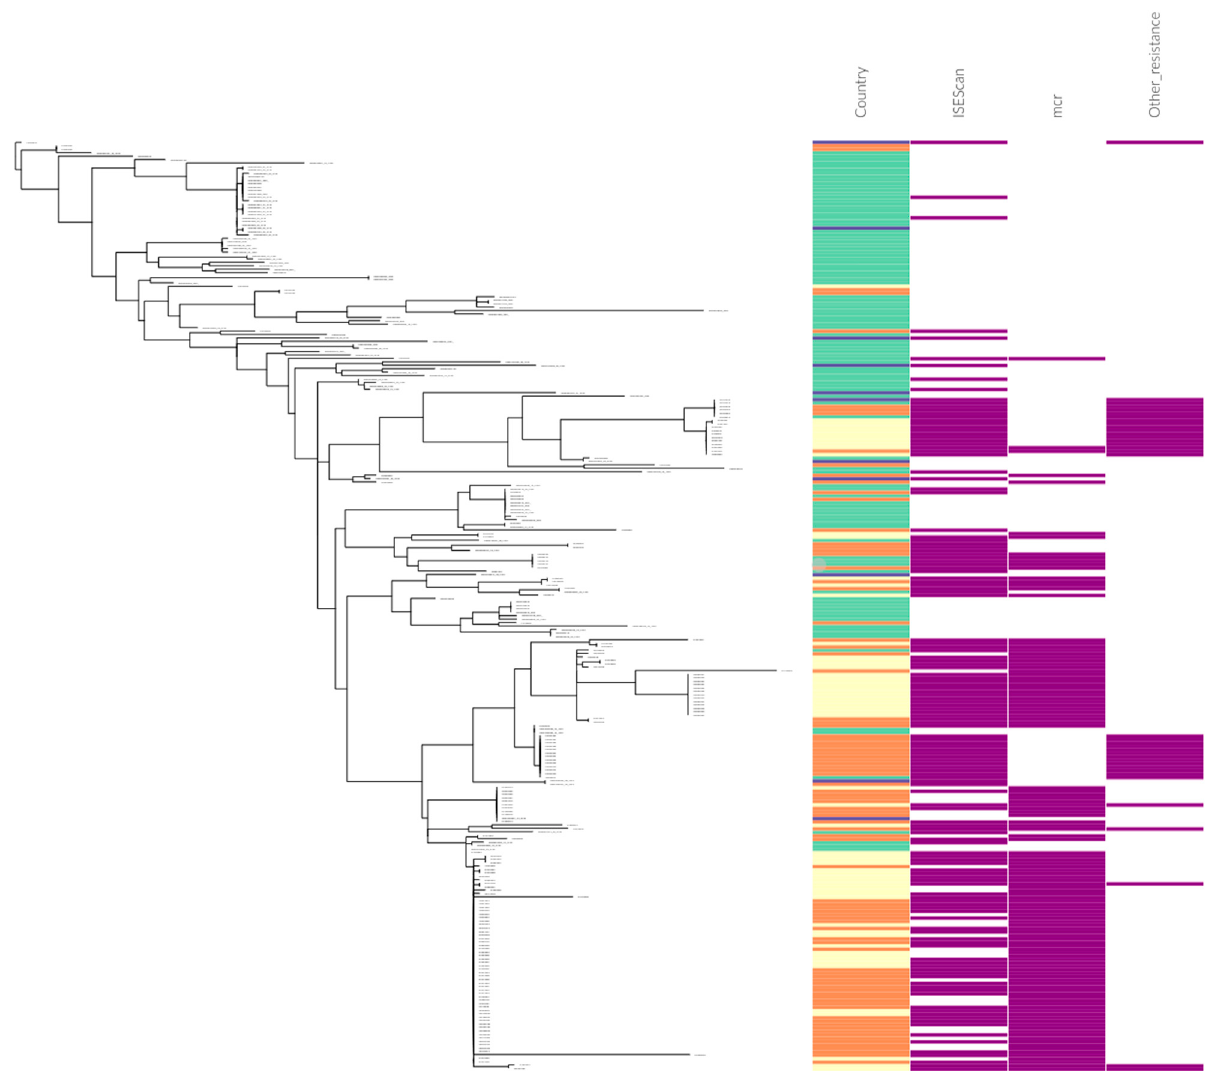
Figure 1. Phylogenetic tree of global IncI2 plasmids based on alignment of core genes (see methods). Country designations are USA (teal), China (beige), UK (blue) and other (orange). The remaining columns are presence or absence of IS elements, mcr genes, or other resistance genes, respectively.